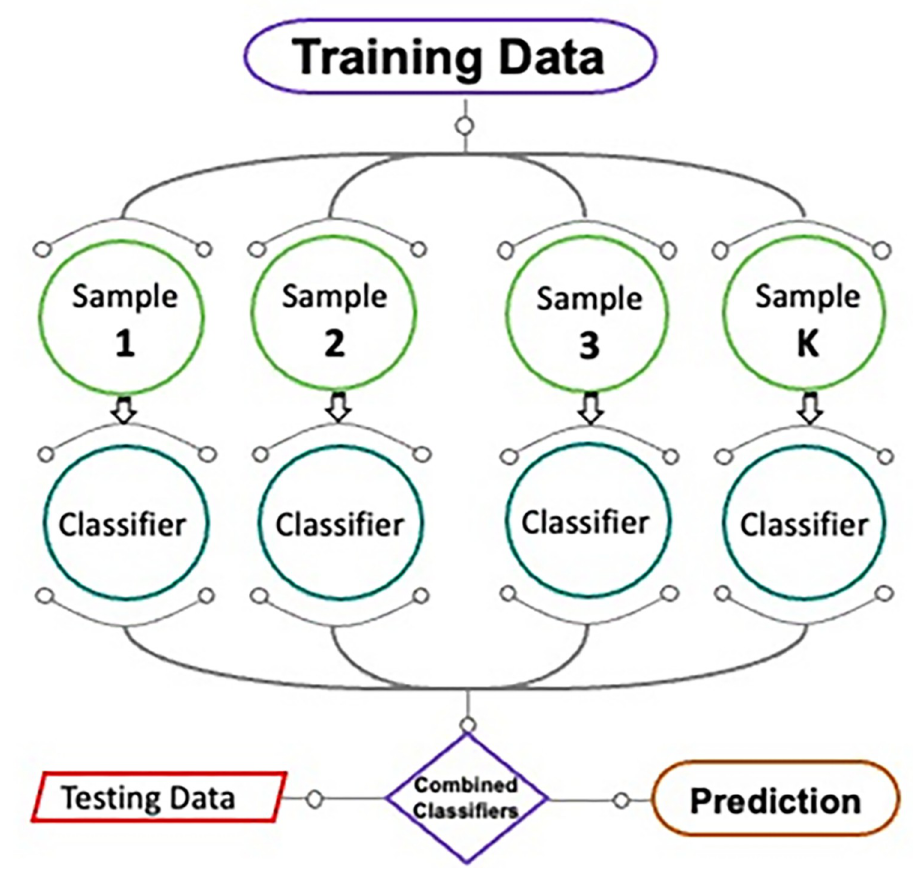
Fig 3. Process of bagging regressor training method